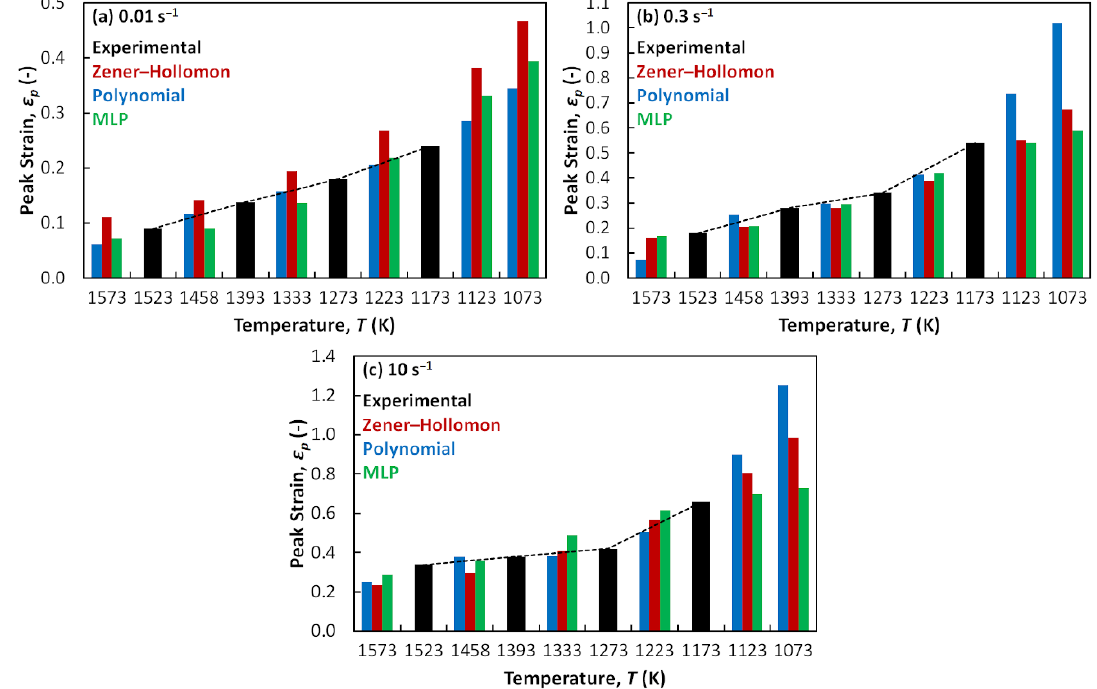
Figure 6. Peak strain prediction inside and outside of the experimental conditions. ( a ) A strain rate of 0.01 s − 1 ; ( b ) a strain rate of 0.3 s − 1 ; and ( c ) a strain rate of 10 s − 1 . Black columns—experimental values; red columns—values predicted via the Zener–Hollomon approach; blue columns—values predicted via the multivariate polynomial approach; and green columns—values predicted via the multi-layer perceptron approach.